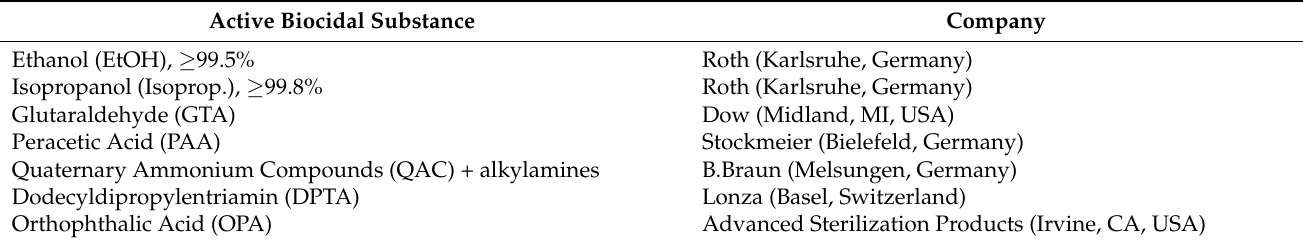
Table 1. Chemical disinfectants